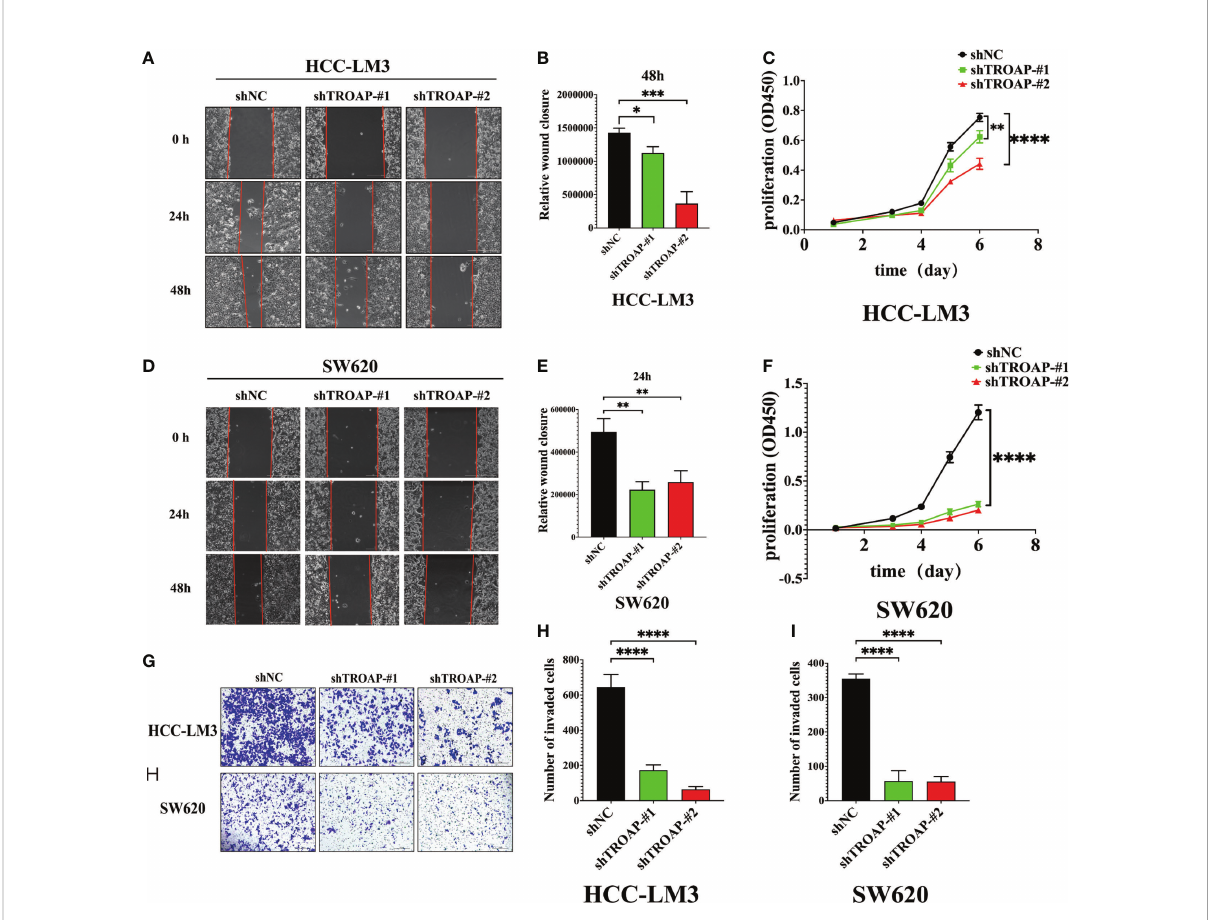
FIGURE 5 Downregulation of TROAP attenuates the malignant proliferation and migration of HCC and SW620 cells in vitro . (A, B, D, E) Wound healing assay, images of the HCC-LM3 and SW620 cells after scratching 0h, 24h, and 48h are shown in (A, D) , and percentages of wound closure were shown in (B, E) ; (C, F) The proliferation rate of HCC-LM3 and SW620 cells after lentivirus-mediated silence of TROAP determined by CCK8 assay; (G-J) Transwell assay to access the effects of TROAP knockdown on cell migration in HCC-LM3 and SW620 cells, quanti fi cation graphs were shown in (I, J) . In panels (B – J) , data are indicated as mean ± SD; two-sided Student ’ s t-test; *P < 0.05; **P < 0.01; ***:P < 0.001 and ****:P <